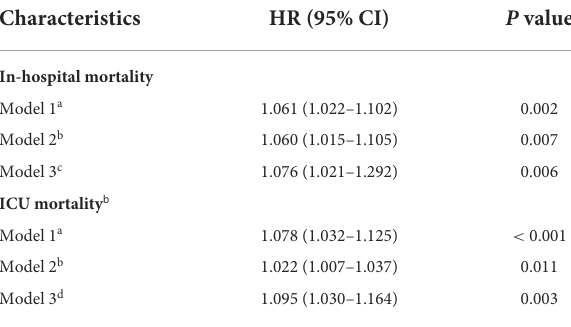
TABLE 2 Association between the anion gap and in-hospital and ICU